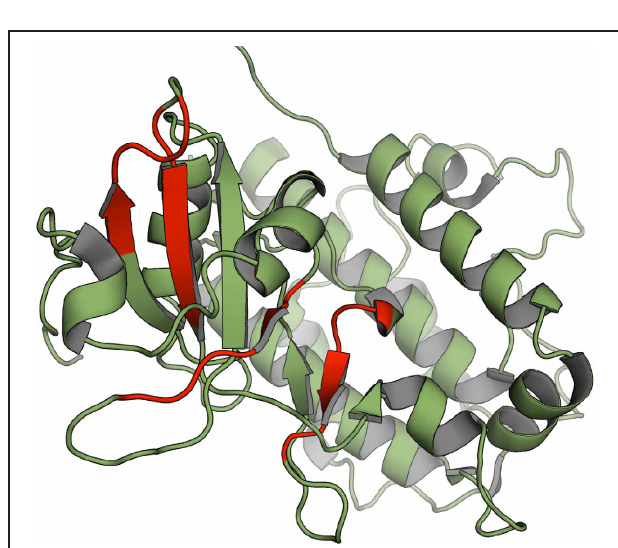
FIGURE 9 | Location of the detected amyloidogenic patterns on the structure of MAPKAPK2 belonging to the CAMK group (PDB 1kwp), amino acid stretches corresponding to the detected patterns are shown in